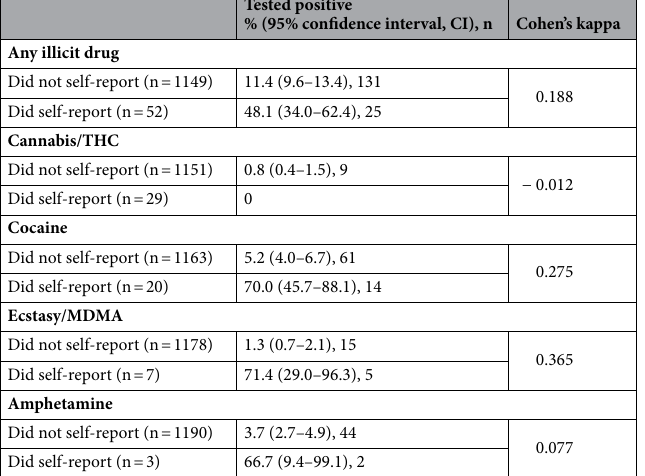
Table 3. Matching self-reported and measured drug use (n = 1201). Data is missing for n = 22 (any illicit drug), n = 43 (cannabis), n = 40 (cocaine), n = 38 (ecstasy), and n = 30